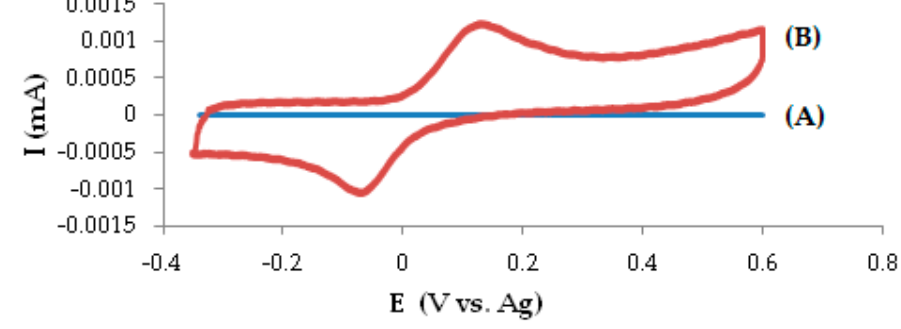
Figure 4. Cyclic Voltammograms of ( A ) Blank electrolyte solution, ( B ) DOPA (2.5 × 10 − 5 M).